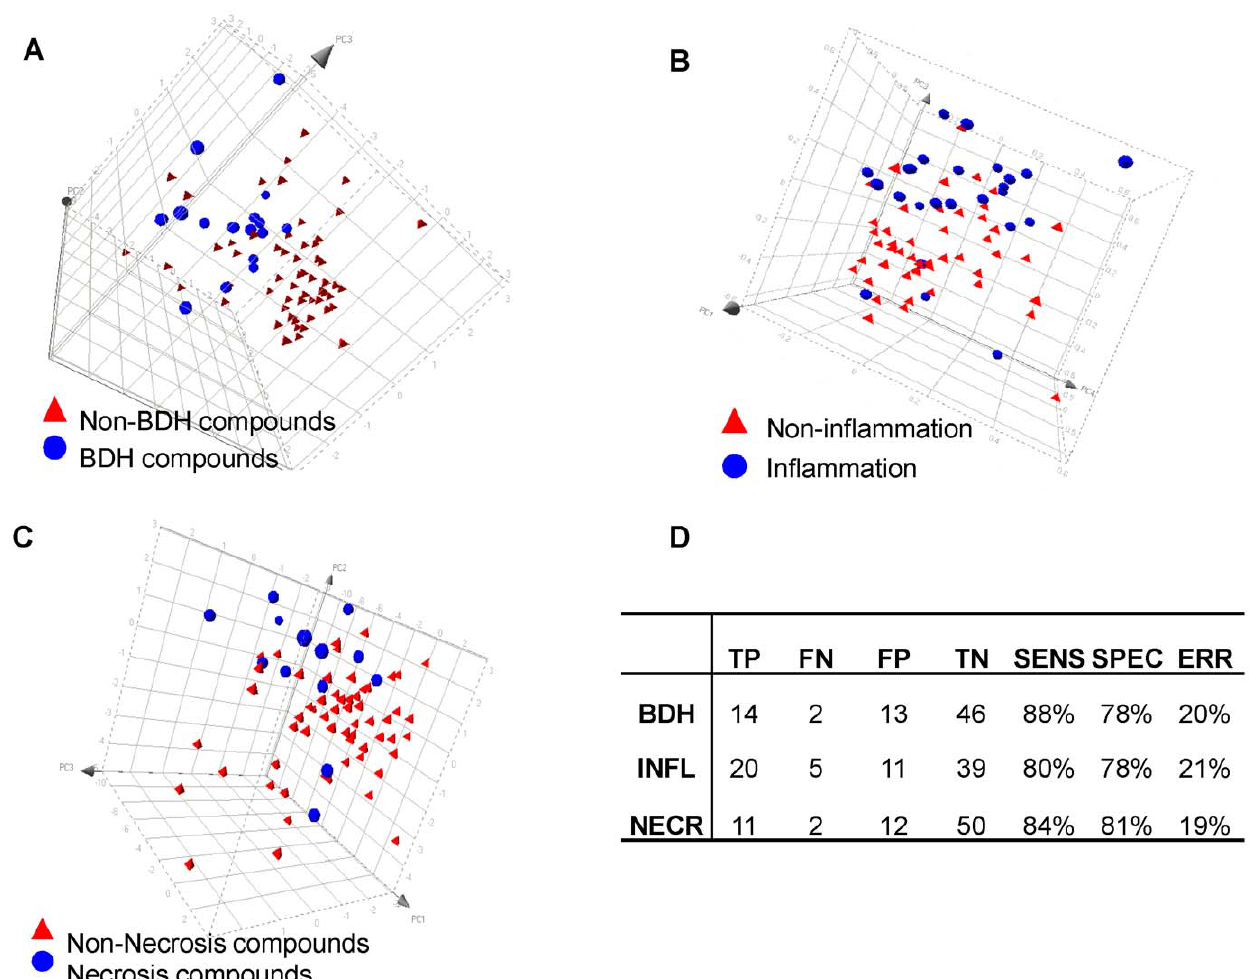
Figure 6. Validation with an independent dataset. Visual representation of PCA results for the top 10 genes in the BDH ( A ), INFL ( B ), and necrosis ( C ) signatures validated with independent samples. The result shows a clear separation between positive and negative compounds; ( D ) a SVM classifier performance matrix shows that a reasonable sensitivity (from 80% to 88%) and specificity (from 78% to 81%) have been achieved for each model. TP - True Positive ; FN - False Negative ; FP - False Positive ; TN - True Negative ; SENS - Sensitivity ; SPEC - Specificity ; ERR - Error rate ; NECR - Necrosis .